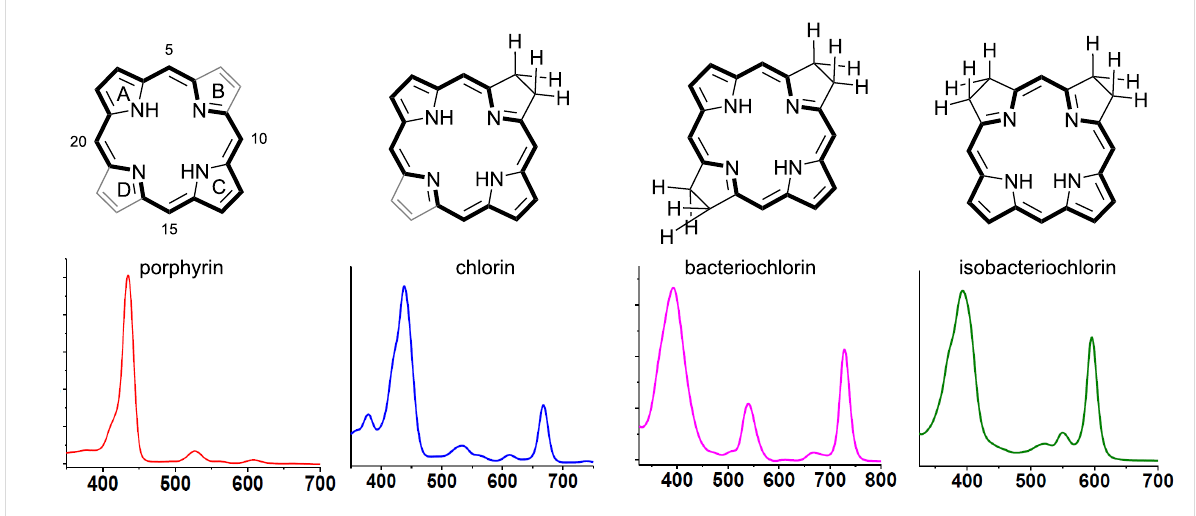
Figure 1: Chemical structures of the porphyrinoids and their absorption spectra: in bold are highlighted the 18 π aromatic system. Adapted from [7].